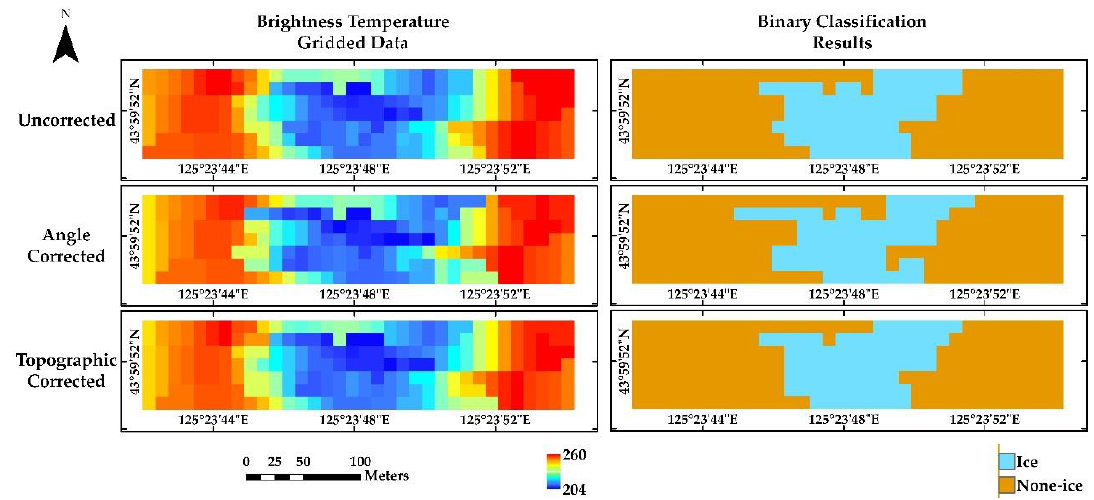
Figure 15. Comparison results for uncorrected, angle-corrected, and topographic-corrected data.